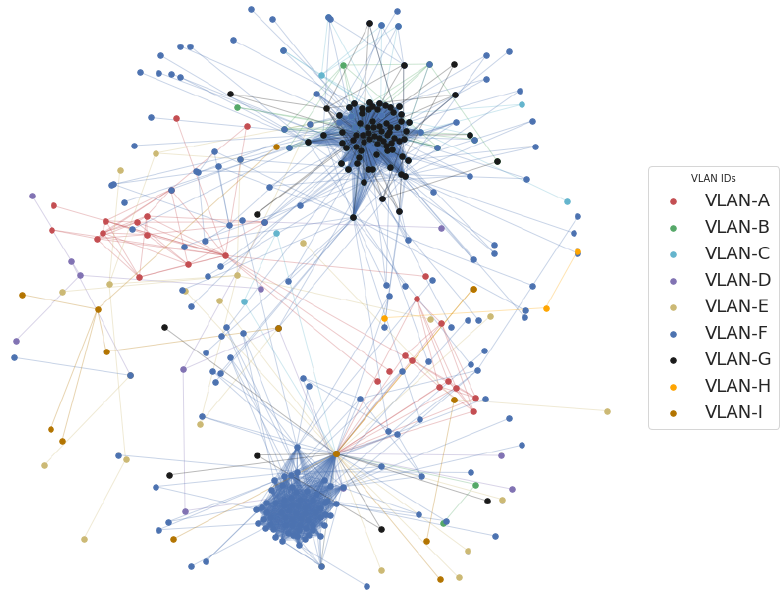
Figure 5. Traffic flows from one of the paperboard machines during recording